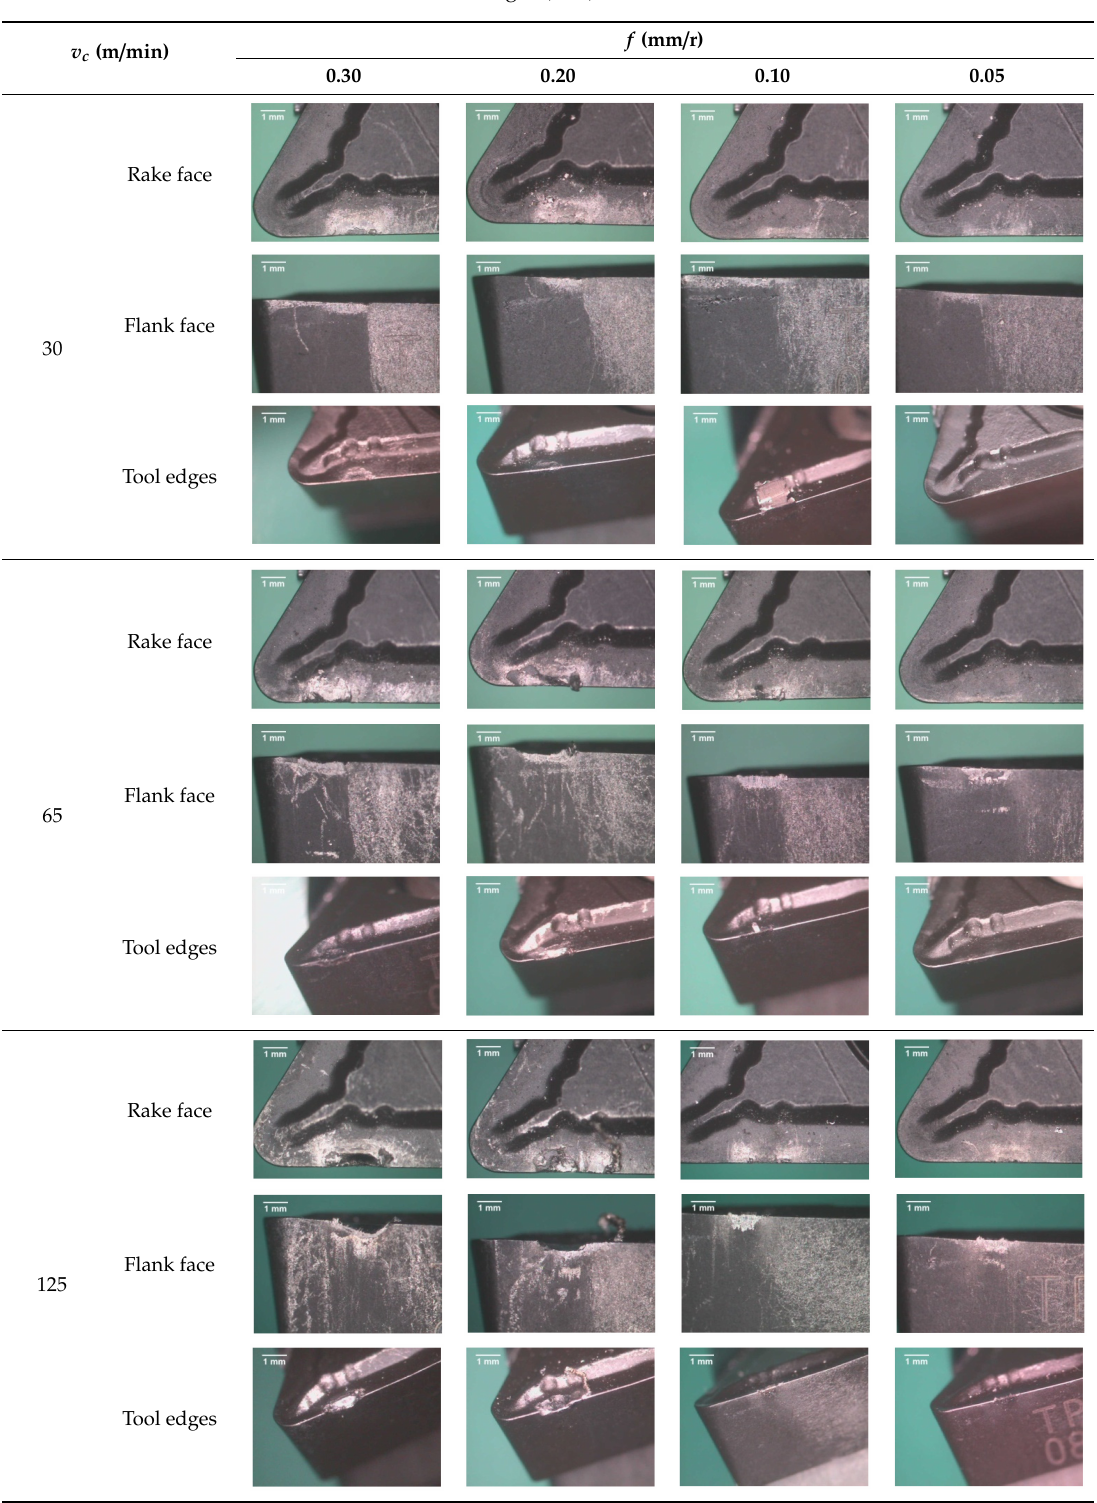
Table 3. SOM images (30 × ) of the tools